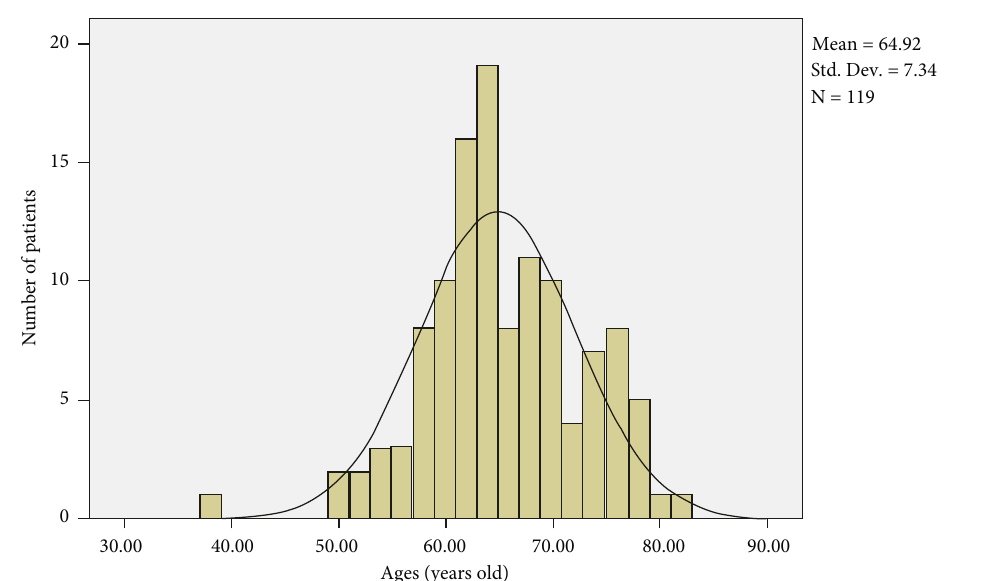
Figure 1: Age distribution.